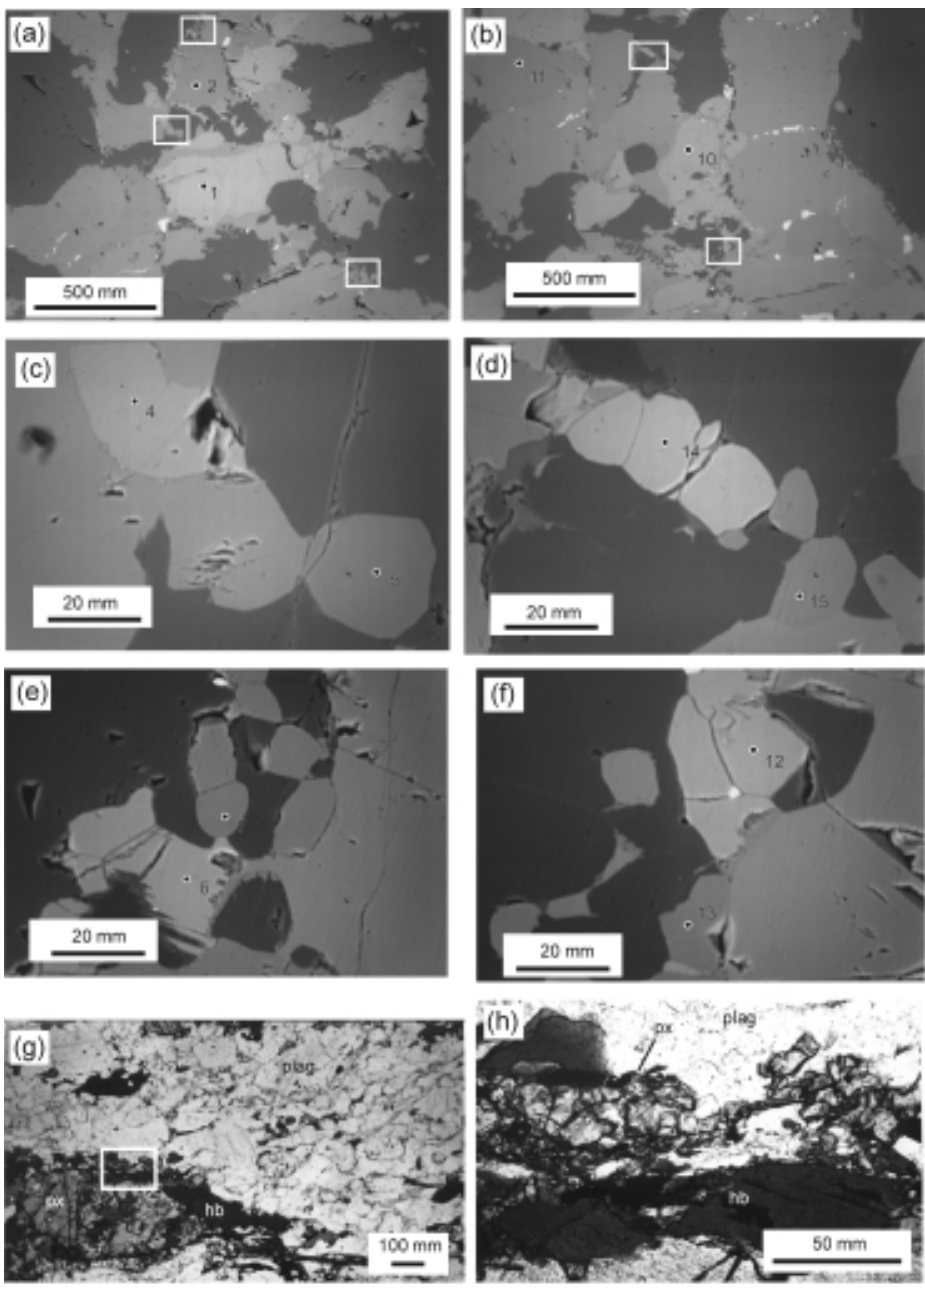
Fig. 6–Sample9, maficgranulite. BSEimagesin(a)-(f)andmicrophotographsin(g)-(h). Granoblastic texture of orthopyroxene, clinopyroxene and plagioclase, rimmed by hornblende, which in turn is rimmed by granoblastic simplectites of orthopyroxene + clinopyroxene + plagioclase + hornblende. All minerals were identified by electron microprobe. Numbered spots are chemical analyses by electron microprobe (Table